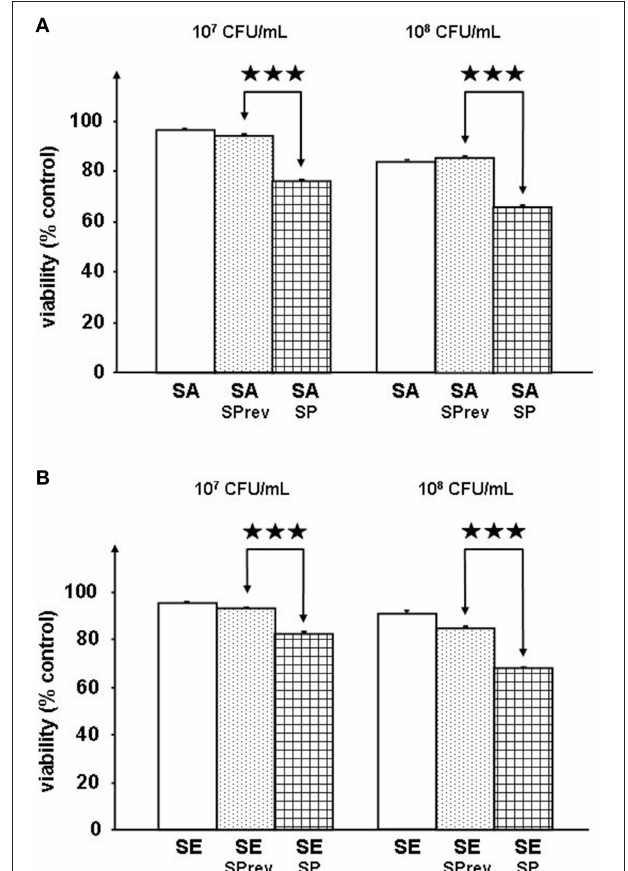
FIGURE 1 | Viability of reconstructed human epidermidis (RHE) exposed to S. aureus MFP03 (A) or S. epidermidis MFP04 (B) (10 7